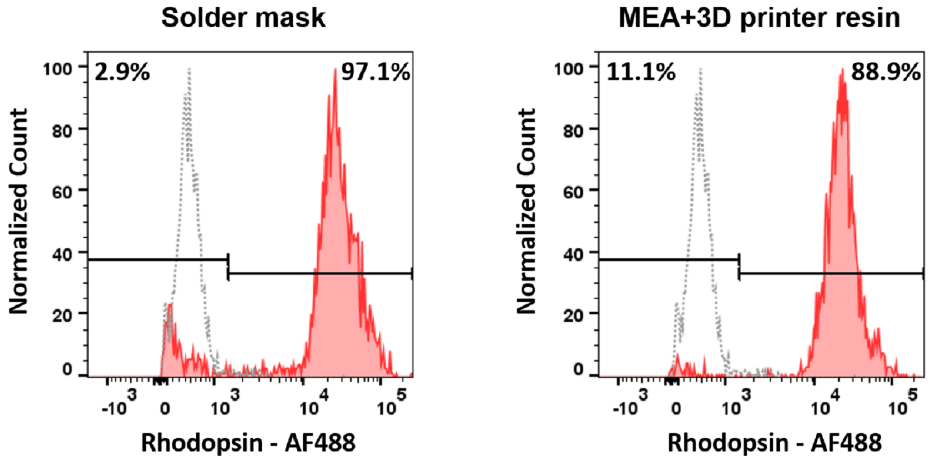
Figure 8. Histograms displaying the percentage of rhodopsin positive cells after culturing retinal explants onto PCB system vs. commercial MEA and 3D printer resin. Fluorescence minus one control (FMO) is displayed in gray as a negative control used for setting the quantification gates.